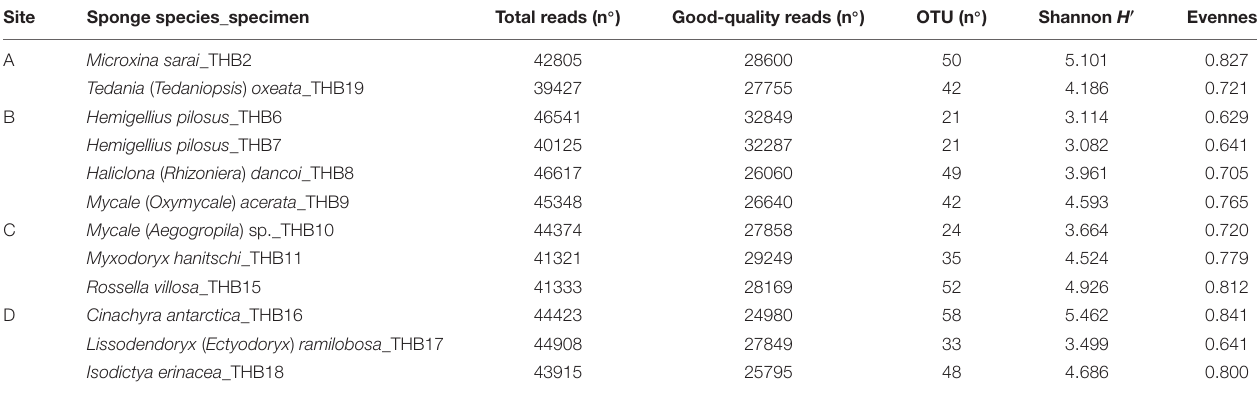
TABLE 3 | Results of the next-generation sequencing analysis and retrieved diversity associated with Antarctic sponge samples. Site Sponge species_specimen Total reads (n ◦